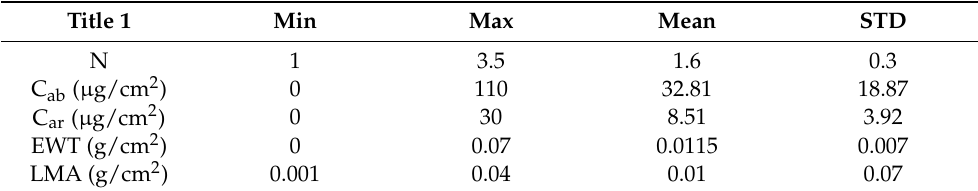
Table 1. Distribution characteristics of the leaf parameters used in the PROSPECT-D simulations for generating the synthetic datasets (STD: standard